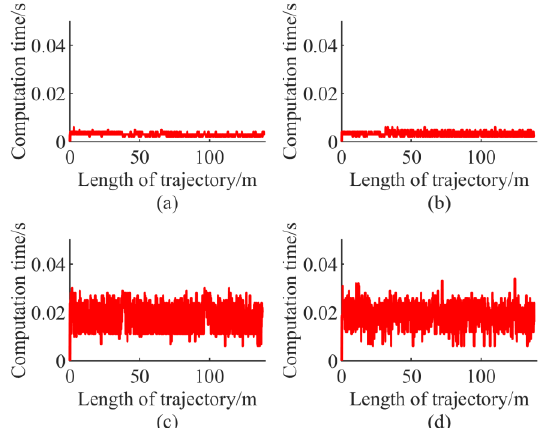
Figure 44. The computation time of the final set of comparison. ( a ) LMPC. ( b ) LEMPC. ( c ) NMPC. ( d ) NEMPC.